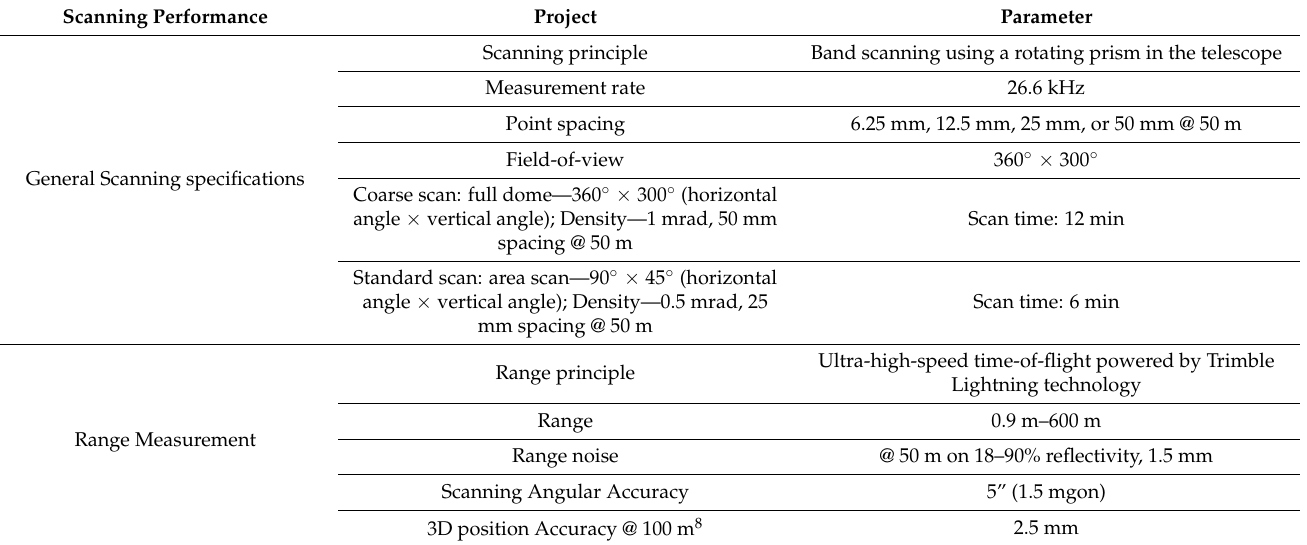
Table 3. Main technical parameters of Trimble SX10